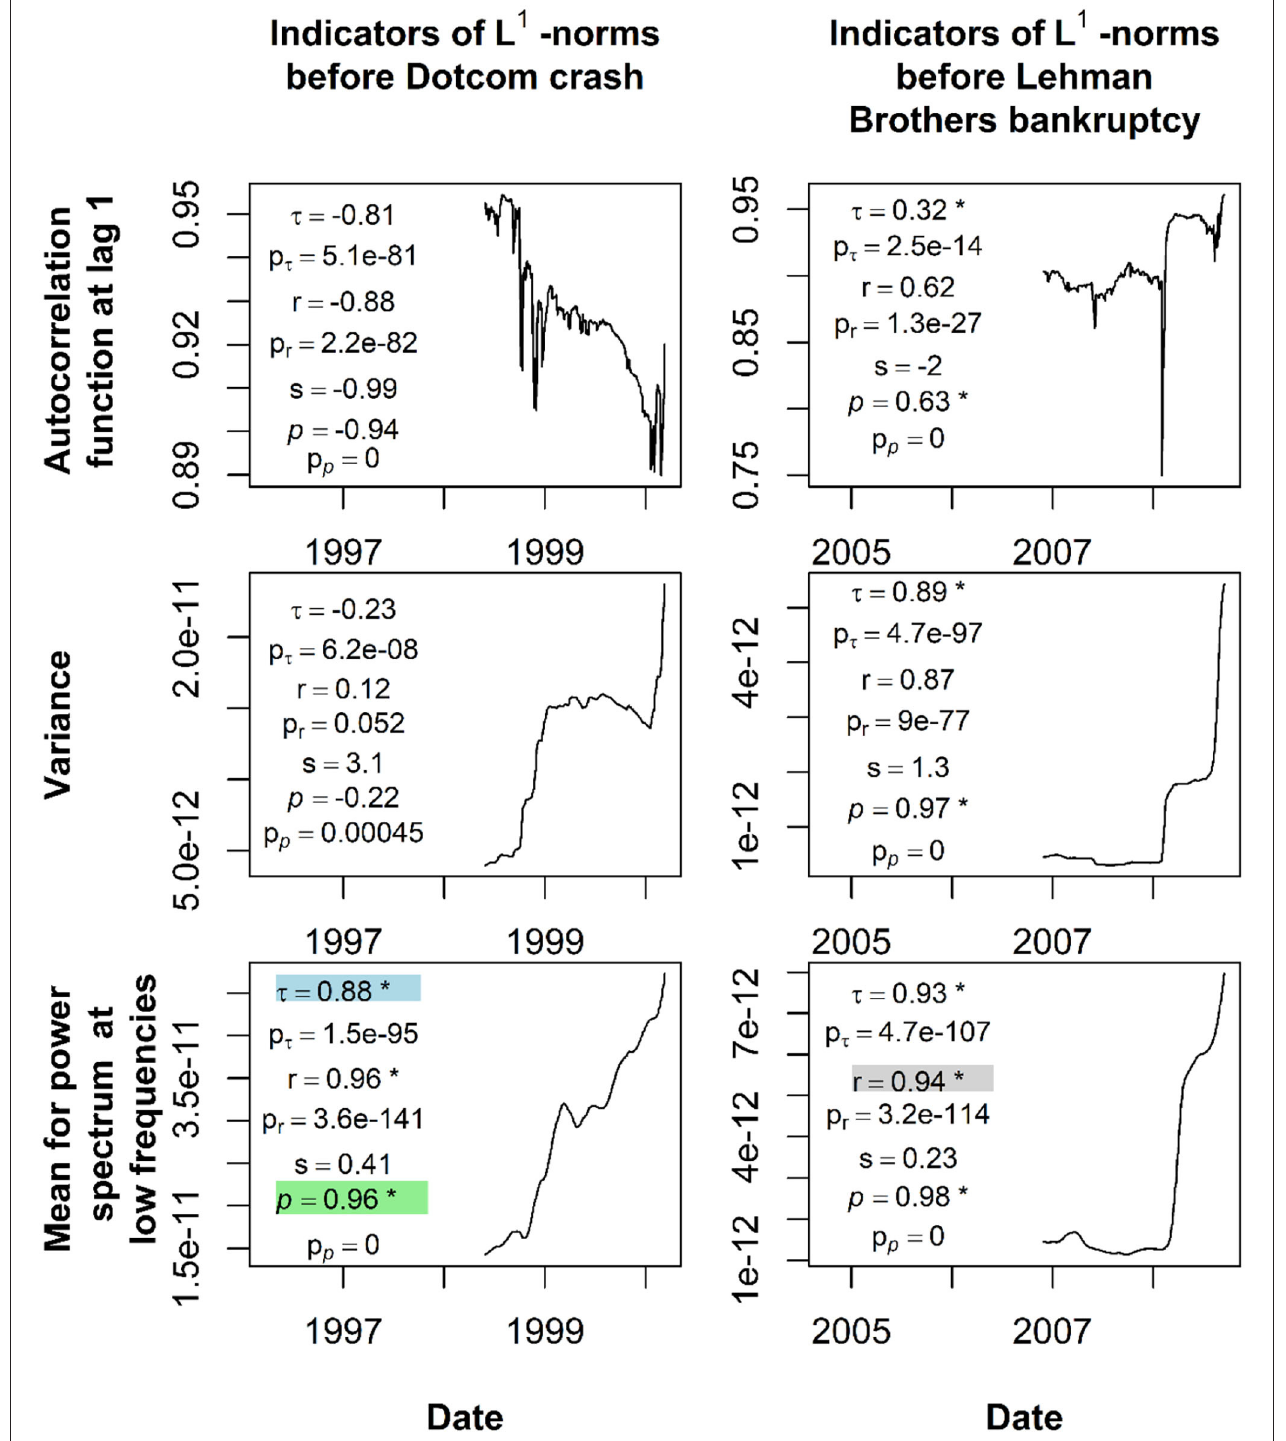
FIGURE 6 | Time series of the CSD indicators (AC1, VAR, and MPS), the obtained value for Kendall’s tau, Pearson’s, and Spearman’s rho correlations, and their corresponding p -values 1 day before the financial crises.